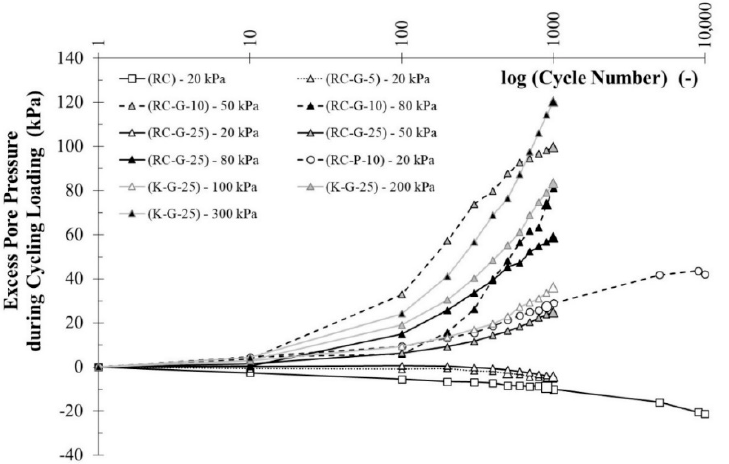
Figure 5. Variation of the pore pressure u cyc with the cycle number N from 1–10 thousand cycles (the horizontal axis is logarithmic).